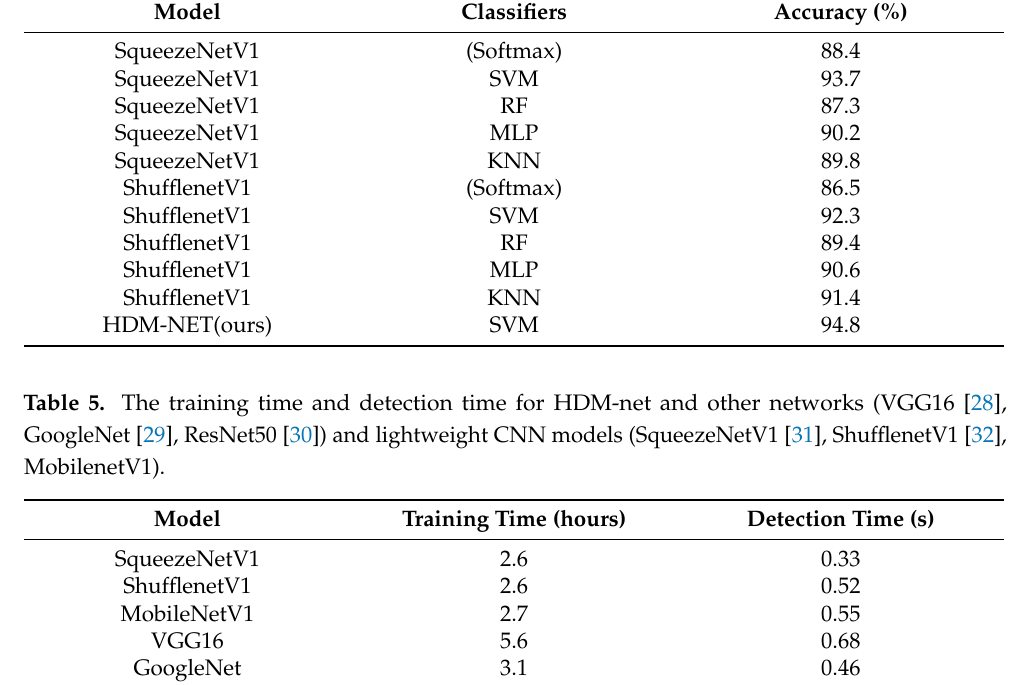
Table 4. Results of HDM-net and other lightweight networks on DHI datasets.